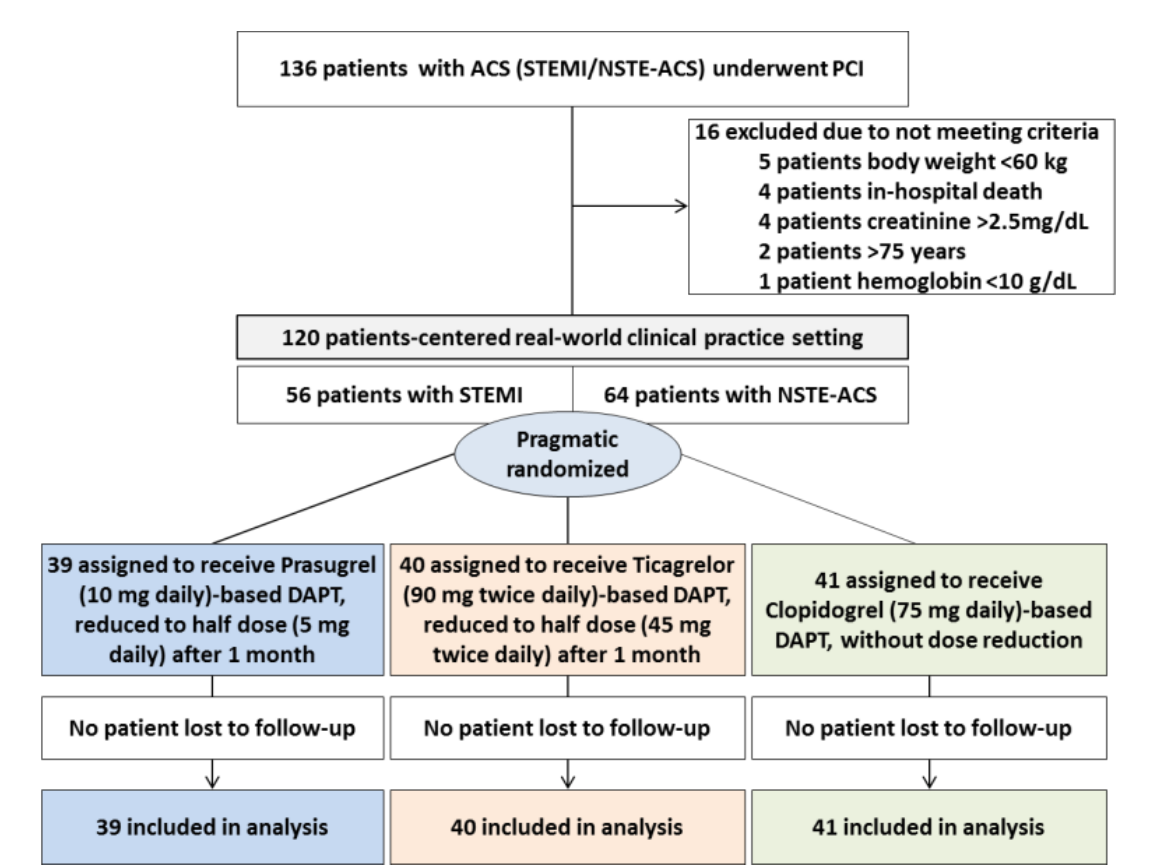
Figure 1. Patient flow and overall clinical trial design.